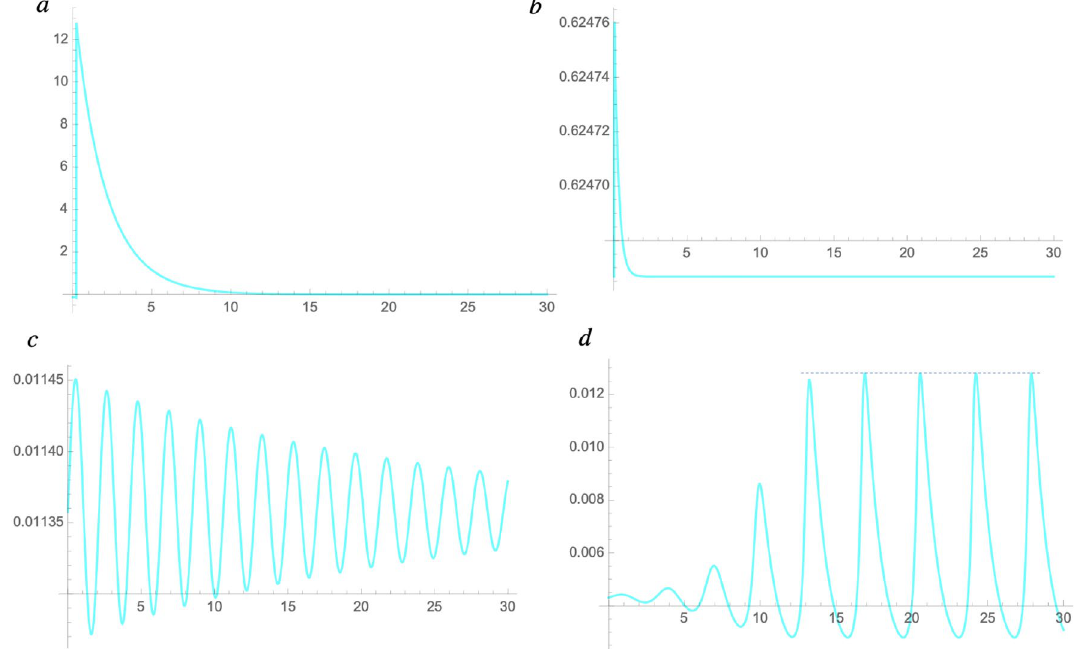
Figure 3. Recovery rate factor and infectious wave. The recovery rate coefficient p is the first order term of z 1 in the right-hand side in Eq. (32). The simulation plots show the relative value corresponding to the new infection number in Kyoto when ( a ) p = 0.5, ( b ) p c = 0.52, ( c ) 0.7, and ( d ) 1.0. ( a ) shows the infection explosion. ( c ) and ( d ) show the simulated infection wave. ( d ) shows that the amplitude approaches a plateau, as indicated by the dotted line. Scales at the horizontal axes represent the relative value, and one scale interval represents 30 days. Scales at the vertical axes represent the relative value corresponding to the infection number when the initial value was set to 10 –4 for the simulation (see method, “Numerical